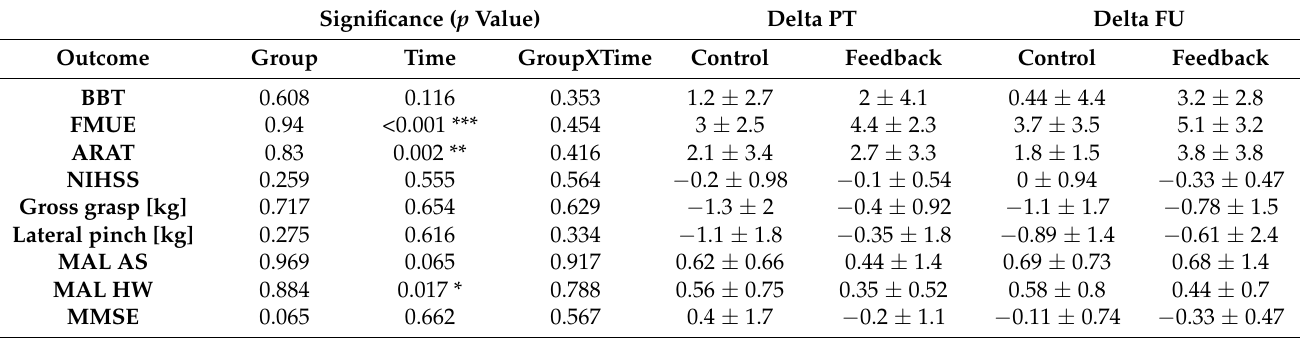
Table 2. Changes in clinical score in the RCT. Delta PT = change from baseline to post-therapy evaluation, Delta FU = change from baseline to follow-up evaluation.